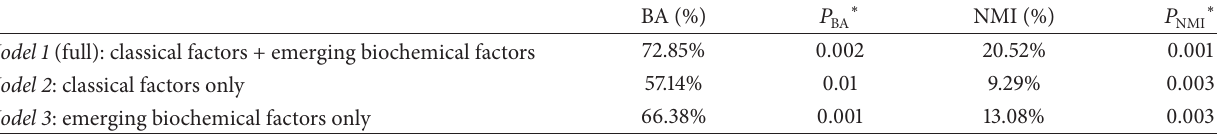
Table 3: Performance of different models for CAD prediction in type 2 diabetes patients.